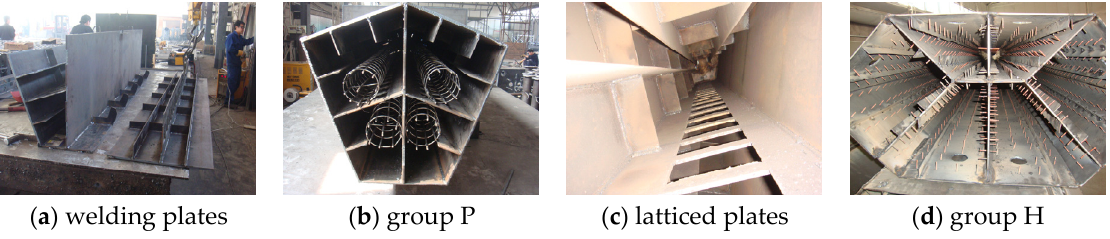
Figure 3. Column construction pictures.